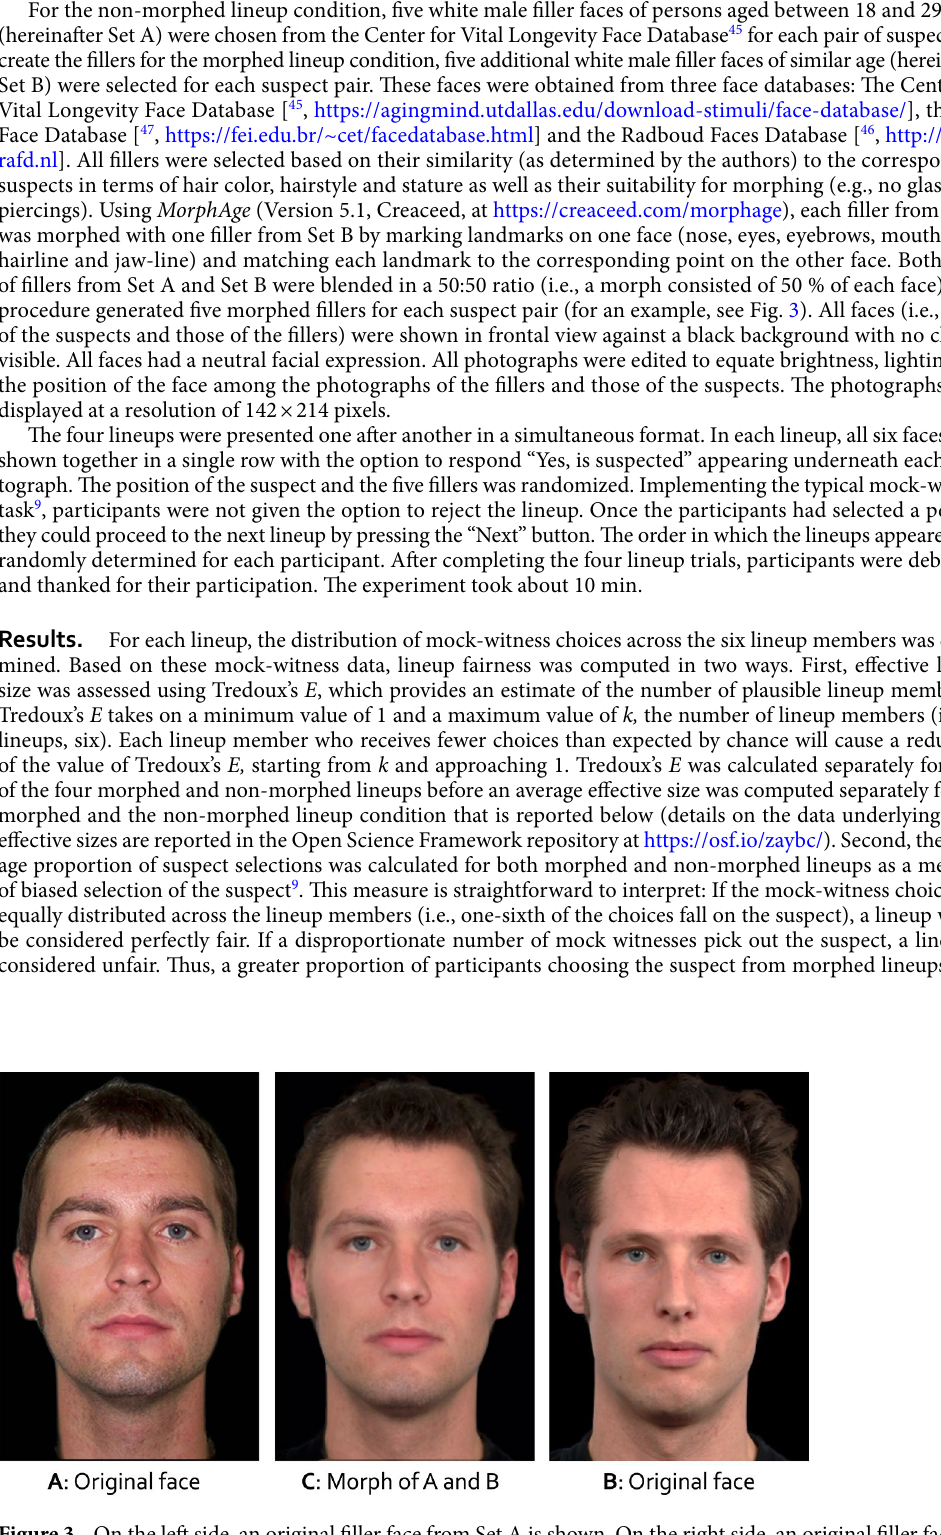
Figure 3. On the left side, an original filler face from Set A is shown. On the right side, an original filler face from Set B is shown. In the center, the face morph is shown (morph rate = 50:50). The photograph on the left was taken from the Center for Vital Longevity Face Database 45 . The photograph on the right was taken from the Radboud Faces Database 46